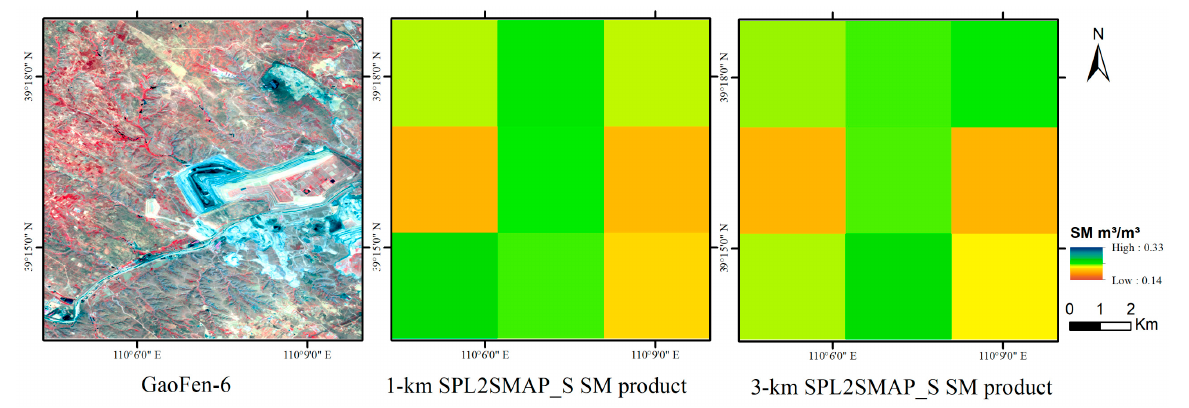
Figure 11. The GaoFen-6 remotely sensed image and the SPL2SMAP_S SM products in the study area.